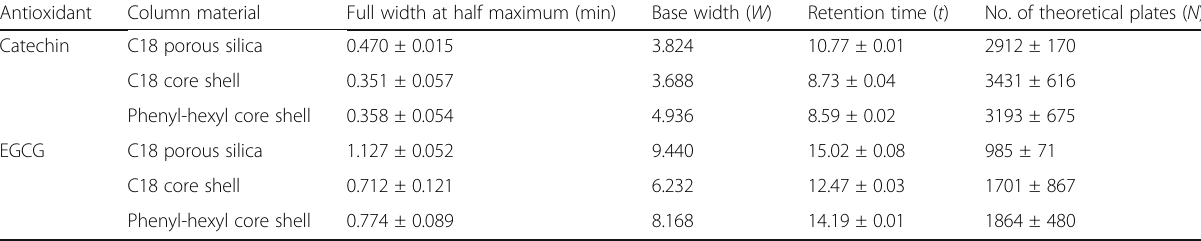
Table 1 Peak and separation characteristics for catechin and EGCG standards